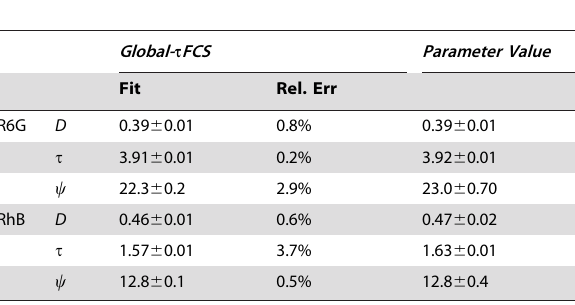
Table 1. Molecular parameter values recovered using Global- t FCS compared to known parameter